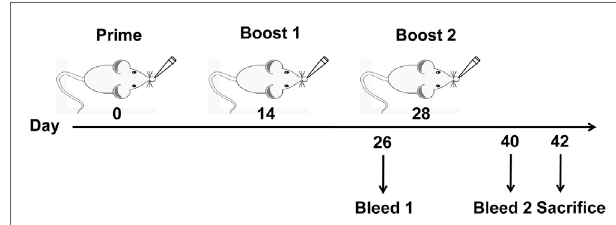
FigUre 1 | Vaccination and blood sample collection schedule . C3H/ HeJ mice ( n = 6 per group) were vaccinated intranasally with three doses of PBS, HA1–2, HA1–2-fliC, or HA1–2 combined with PEI or CTB on days 0, 14, and 28. Animals were bled on days 26 and 40 following the second and third immunizations. Resultant serum samples were used to assess serum antibody responses, and all mice were sacrificed on day 42 to evaluate cellular immune